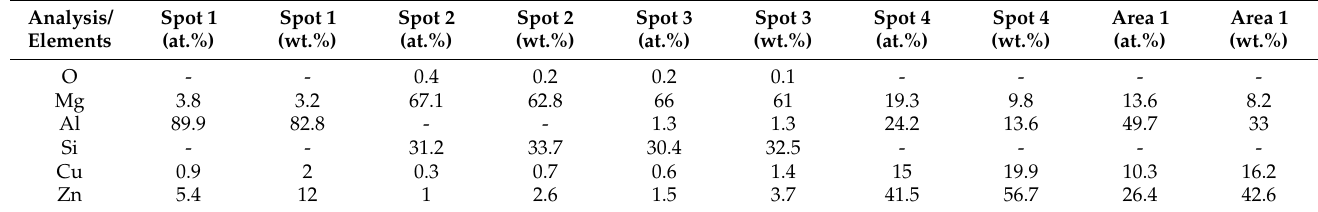
Figure 6. FESEM backscatter electron microstructure with EDS on selected phases for specimen 1M. Table 5. Elemental composition of the manufactured alloy in sample 1M obtained by EDS. Analysis/ Spot 1 Elements (at.%)